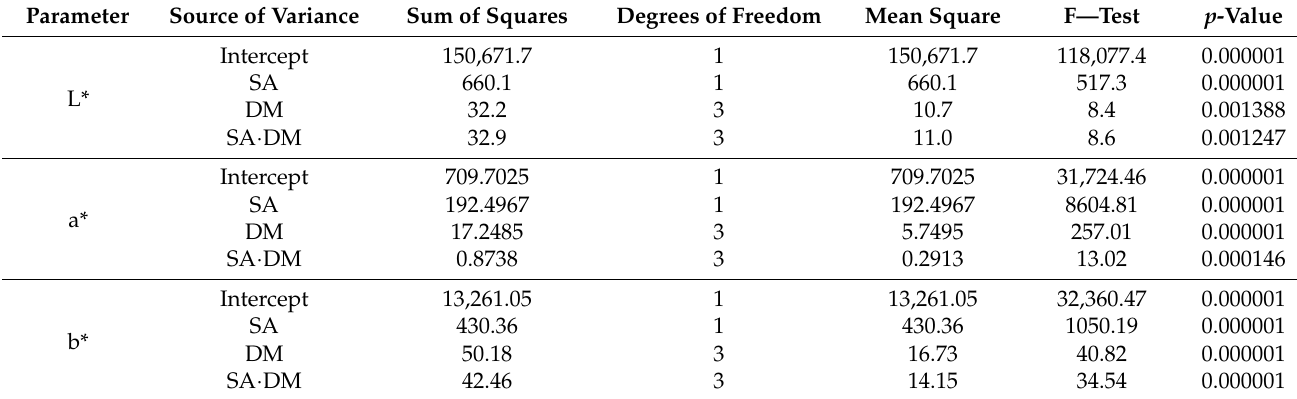
Table 4. The analysis of variance for parameters characterizing the color of dried